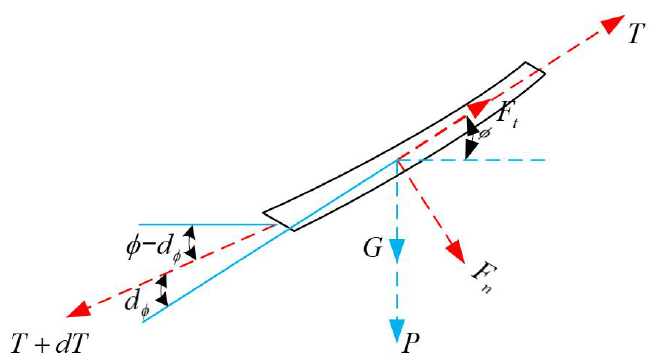
Figure 14. Hydrodynamic force analysis of the EOM cable with attached ballast.